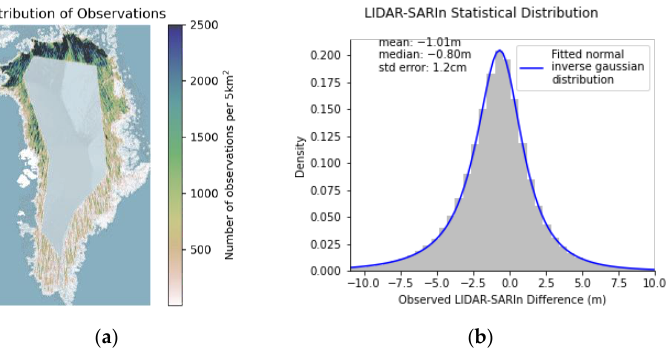
Figure 1. ( a ) The geographical distribution of the ~29 million collocated SARIn vs. LIDAR observa- tions in this study and ( b ) the statistical distribution of the same observations with a fitted normal inverse Gaussian distribution trend line. (c.f. Section 3.2 for details on the standard error calcula-